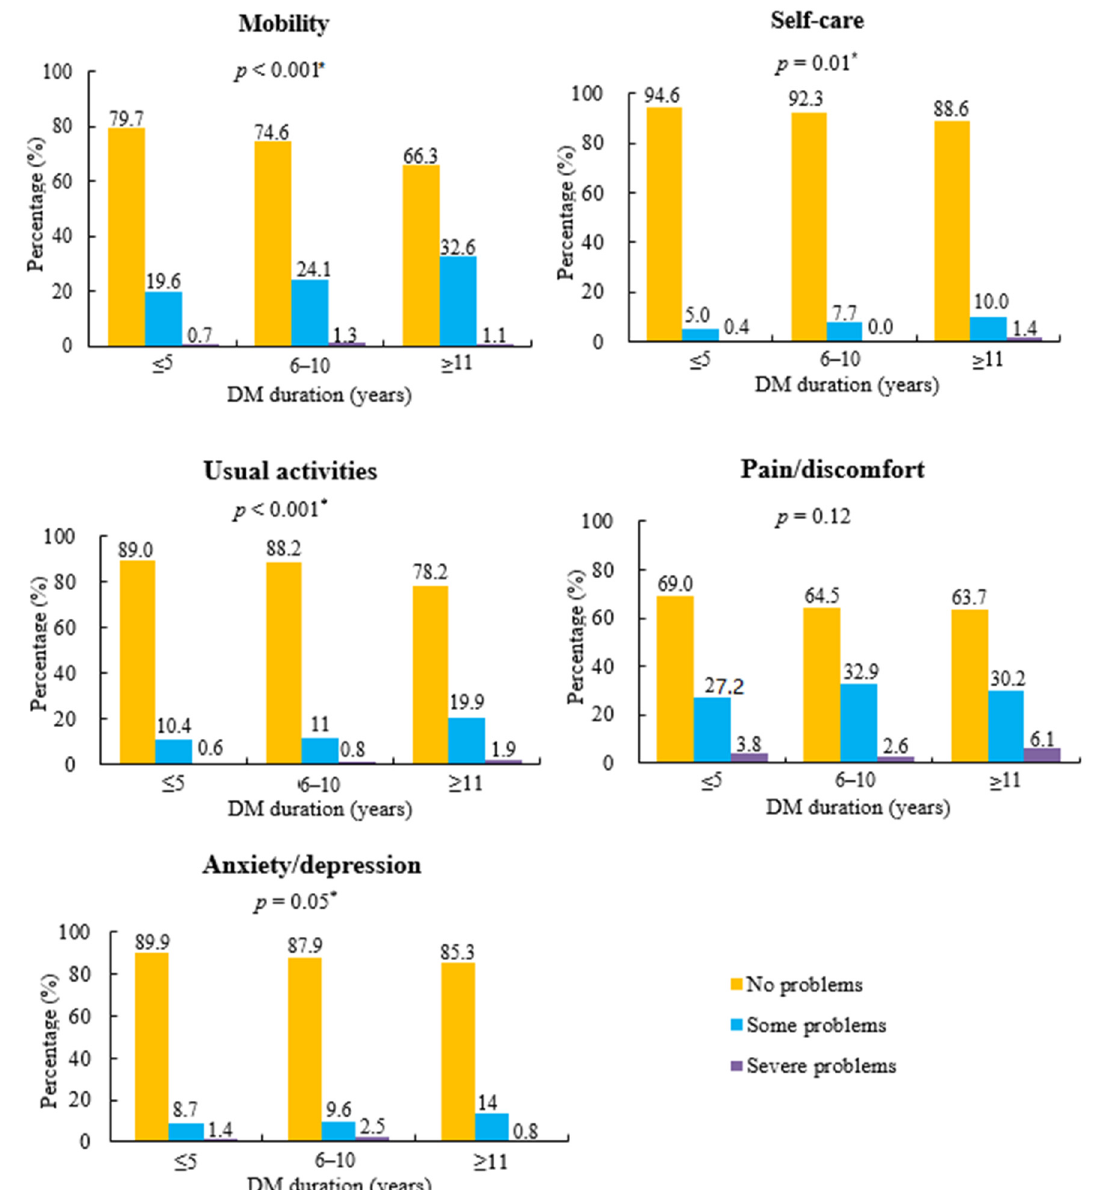
Figure 2. Distribution of perceived problem levels in each health domain of the EQ-5D by diabetes duration. * Significance level among three groups of diabetes mellitus (DM) duration by complex-sample chi-square test.